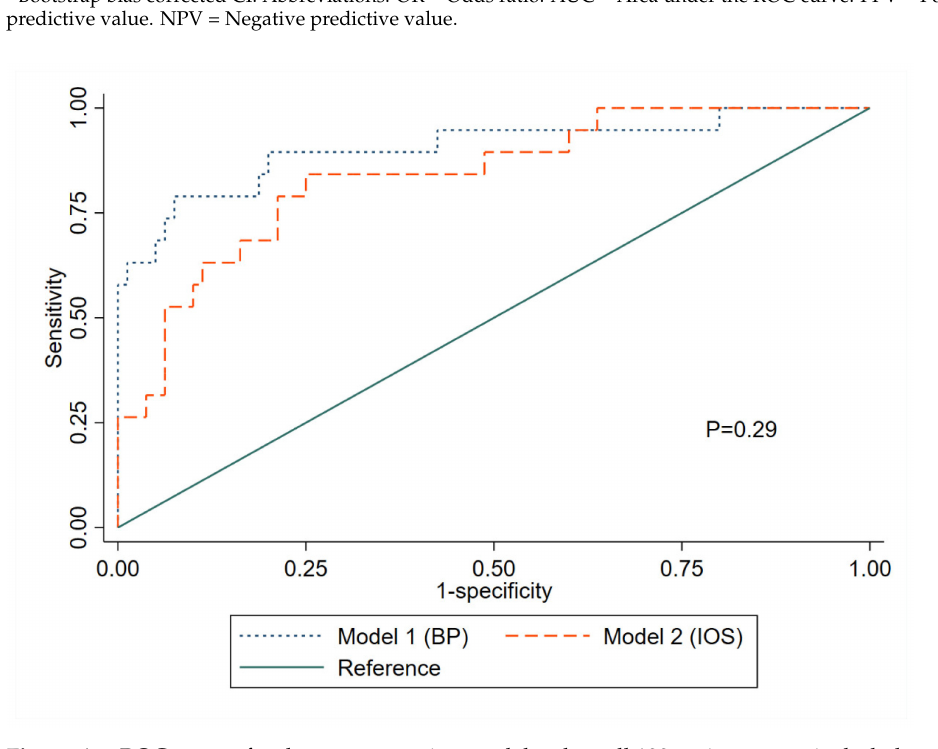
Figure A1. ROC curves for the two regression models when all 100 patients were